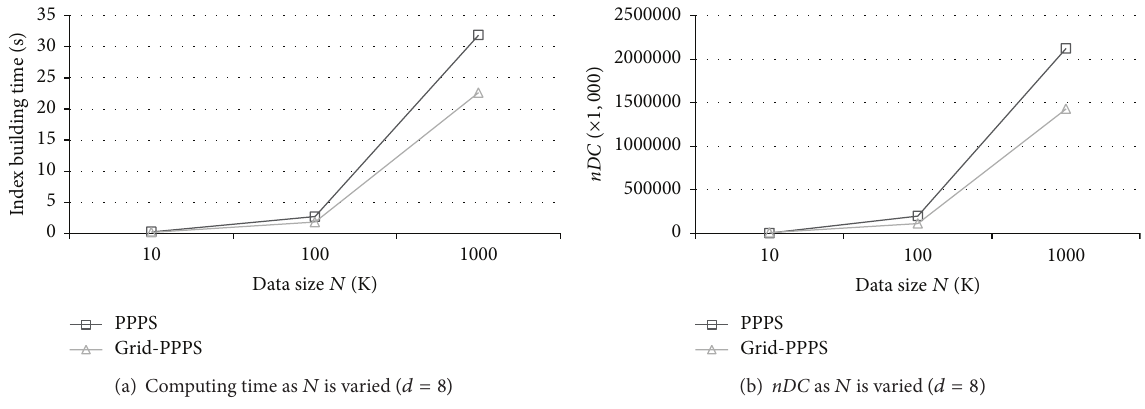
Figure 4: The comparison of the computing time and nDC as 𝑁 is varied related to Experiment